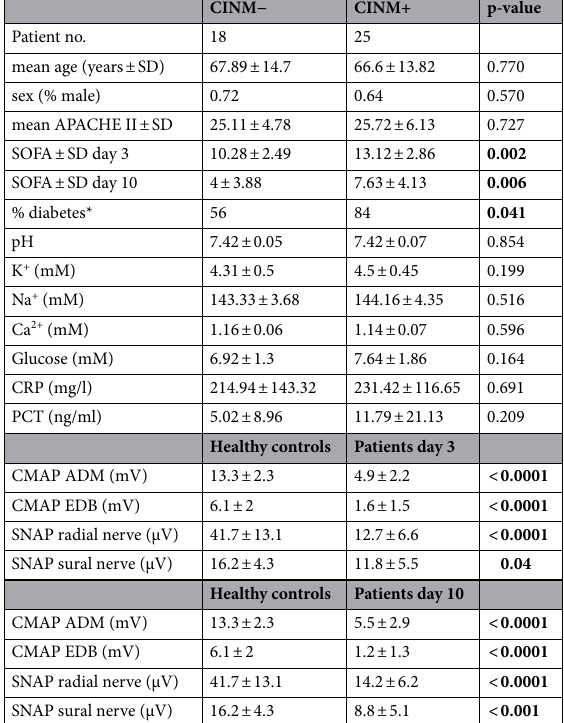
Table 2. Clinical and laboratory characteristics of patients according to their ICU-AW status at day 10 of their critical illness; p-values that indicate significant differences are printed in bold. Demographic and clinical parameters except for the SOFA-score refer to the day of admission, laboratory parameters refer to day 3. For numerical data, p-values were calculated using t-tests for independent samples. For categorical data, χ 2 tests were used. *Only patients without manifest diabetic polyneuropathy were included in this